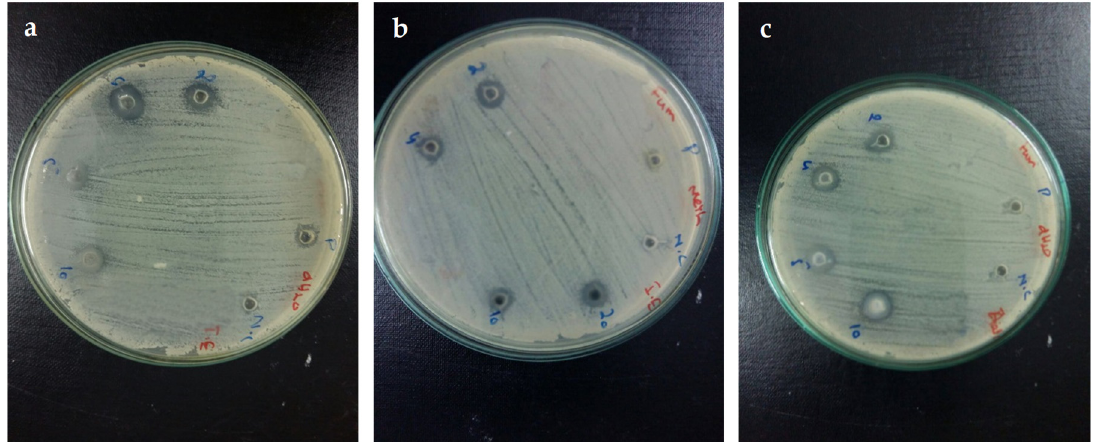
Figure 5. NPs activity against ( a ) S. aureus , ( b ) K. pneumonia , ( c ) P. aeruginosa. The experiments were carried out in triplicate. The values given in Table 1, expressed as mean ± standard deviation of the original data.